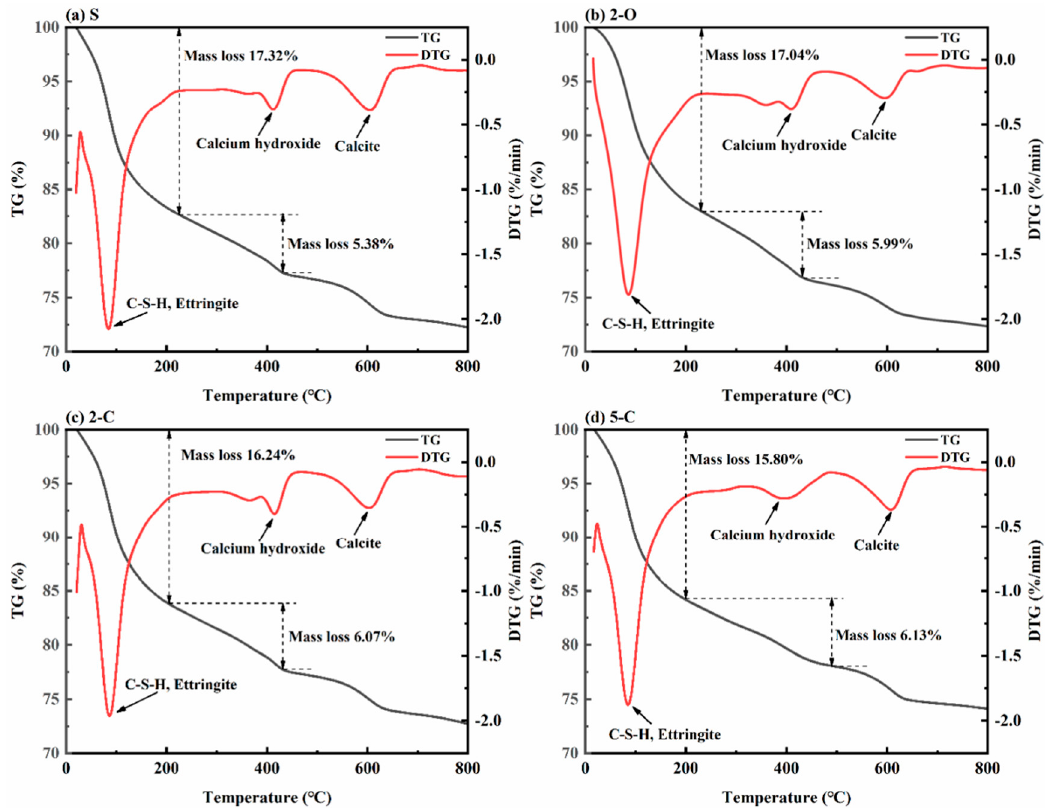
Figure 13. TG/DTG curves of specimens under sulfate attack (a: the S specimen; b: the 2-O specimen; c: the 2-C specimen; d: the 5-C specimen).